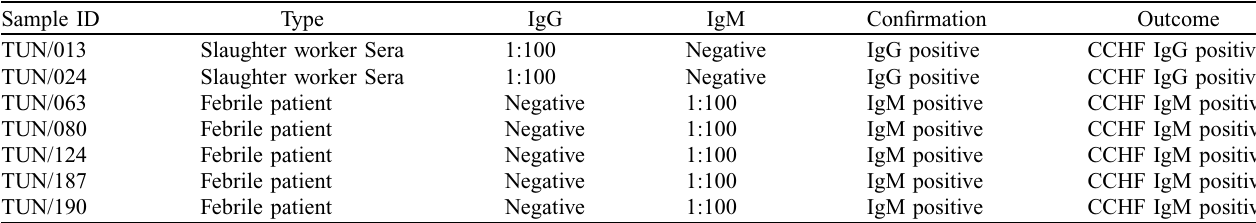
Table 1. List of positive samples, cohorts they belong to, and the associated